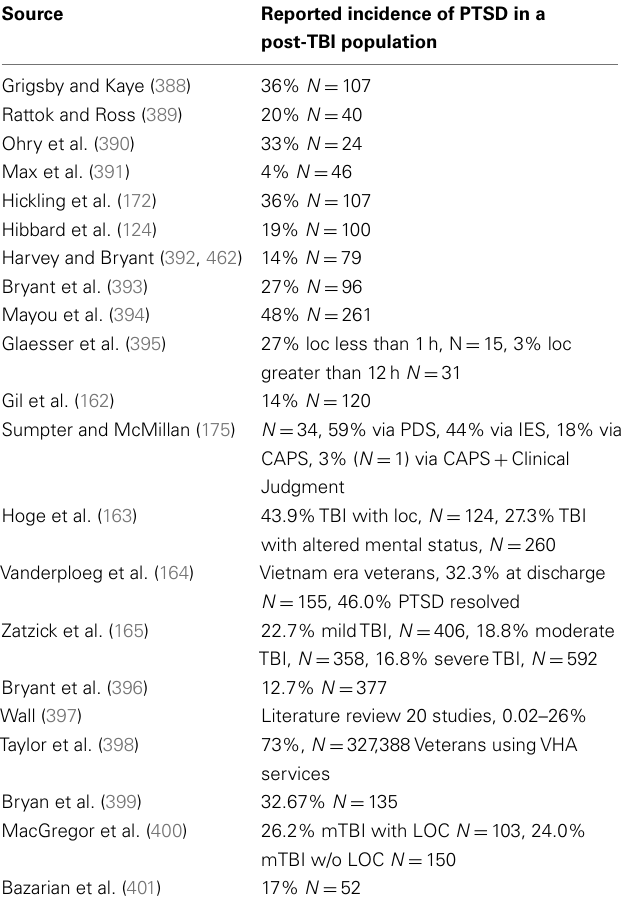
Table 8 | Incidence of PTSD in aTBI